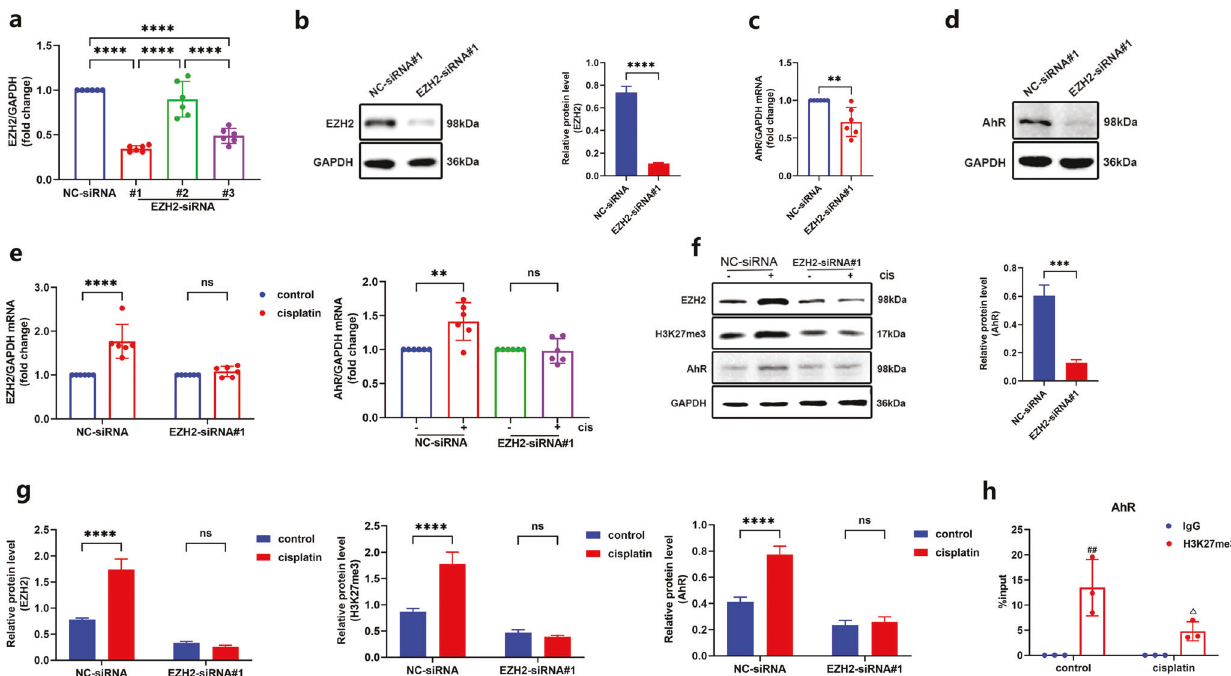
Fig. 7 EZH2 reversely regulated AhR expression in cisplatin-stimulated tubular epithelial TCMK-1 cells. a Screening for suitable EZH2- siRNA through mRNA expression level. b EZH2 protein in negative control (NC)-siRNA and EZH2-siRNA#1 TCMK-1 cells, and the relative protein was quanti fi ed by densitometry and normalized with GAPDH ( n = 3). c Transcript expression ( n = 6) and d protein level ( n = 3) of AhR in NC- siRNA and EZH2-siRNA#1 TCMK-1 cells. e Transcript expression ( n = 6) and f protein level ( n = 3) of EZH2 and AhR in NC-siRNA and EZH2- siRNA#1 TCMK-1 cells with or without cisplatin stimulation, g The relative protein level of them were quanti fi ed by densitometry and normalized with GAPDH ( n = 3), all western blot experiments were repeated in triplicate, **** P < 0.0001, *** P < 0.001, ** p < 0.01, ns P >